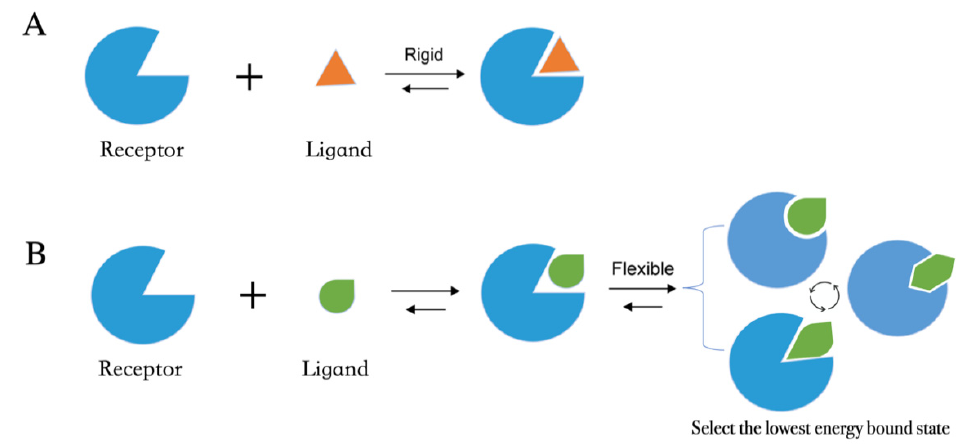
Figure 2. Two models of molecular docking. ( A ) A lock-and-key model. ( B ) Induced fit